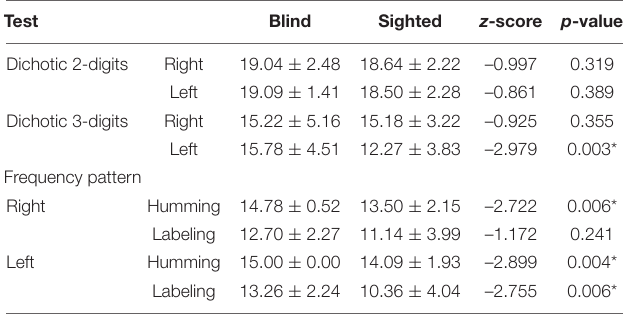
TABLE 2 | Statistical results of dichotic digit test and frequency pattern test.